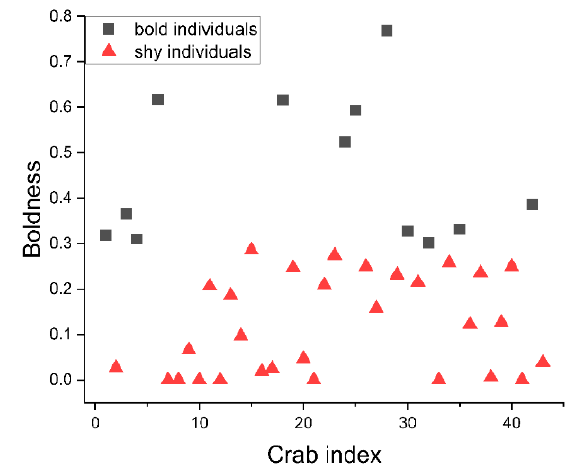
Figure 2. The result of clustering analysis based on boldness.